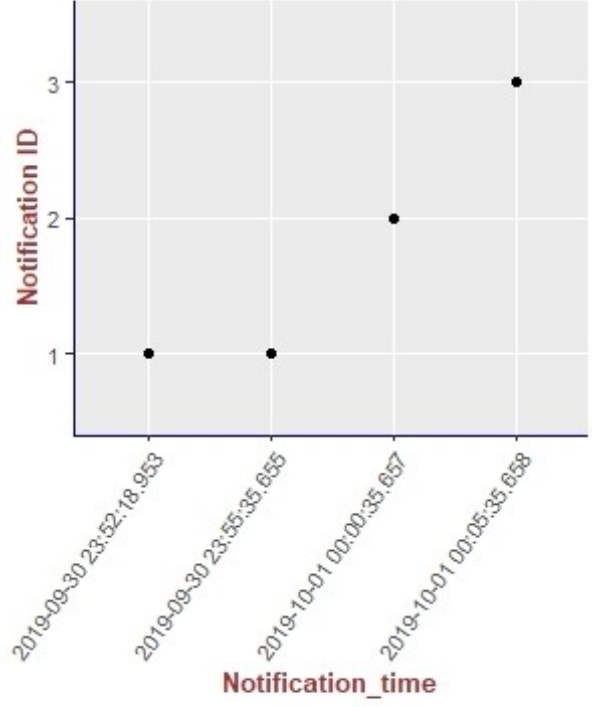
Figure 15. Illustration of the results of the delivery process related to all our experiments.